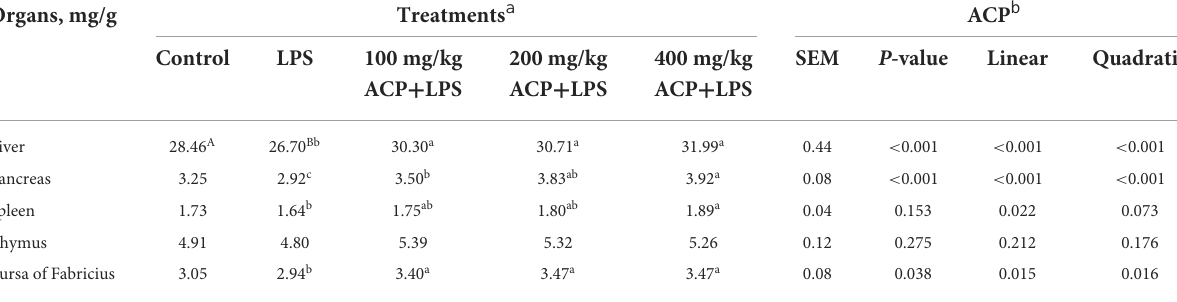
TABLE 3 Effects of Antrodia cinnamomea polysaccharide on organs indices of slow-growing broiler breeds challenged with LPS. Organs, mg/g